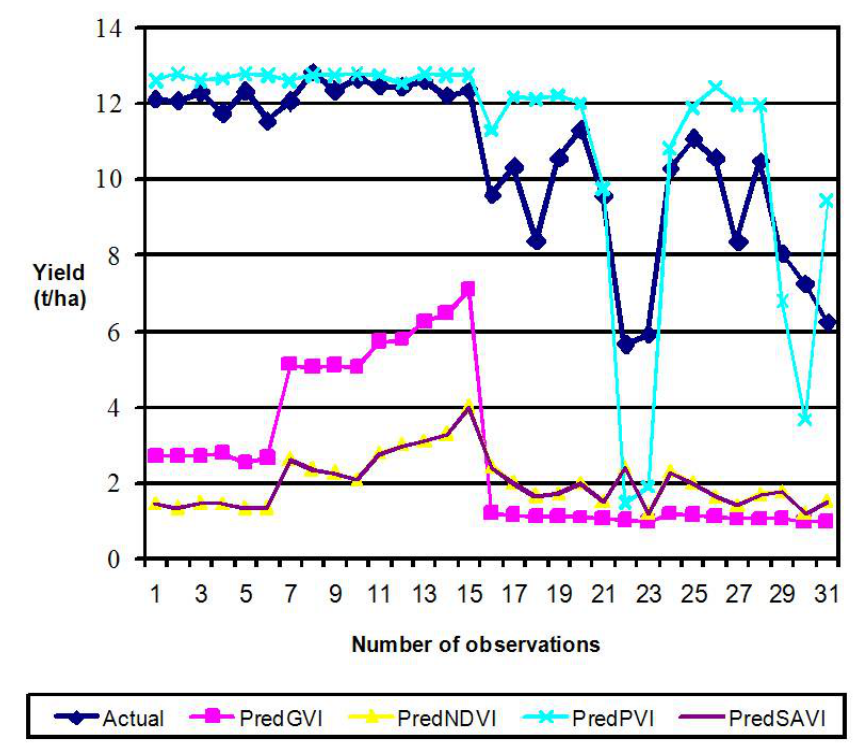
Figure 9. Comparison of VI-NN model prediction ability for the year